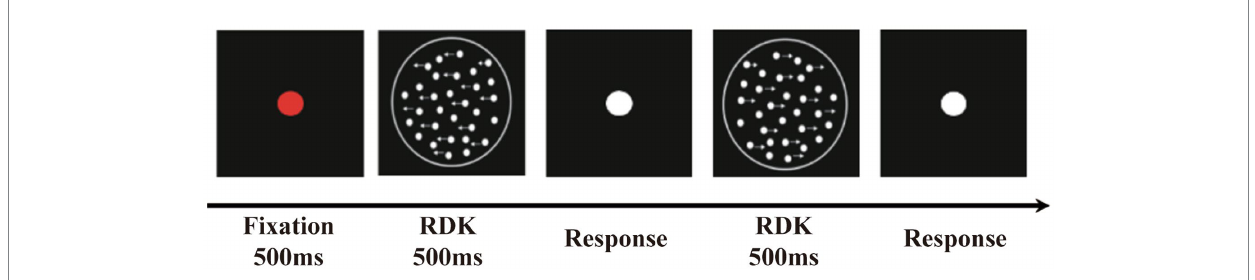
FIGURE 1 The random dot kinematogram paradigm (RDK). The stimuli contained some white luminance dots moved horizontally to the left or right coherently (signal dots) and other dots moved randomly (noise